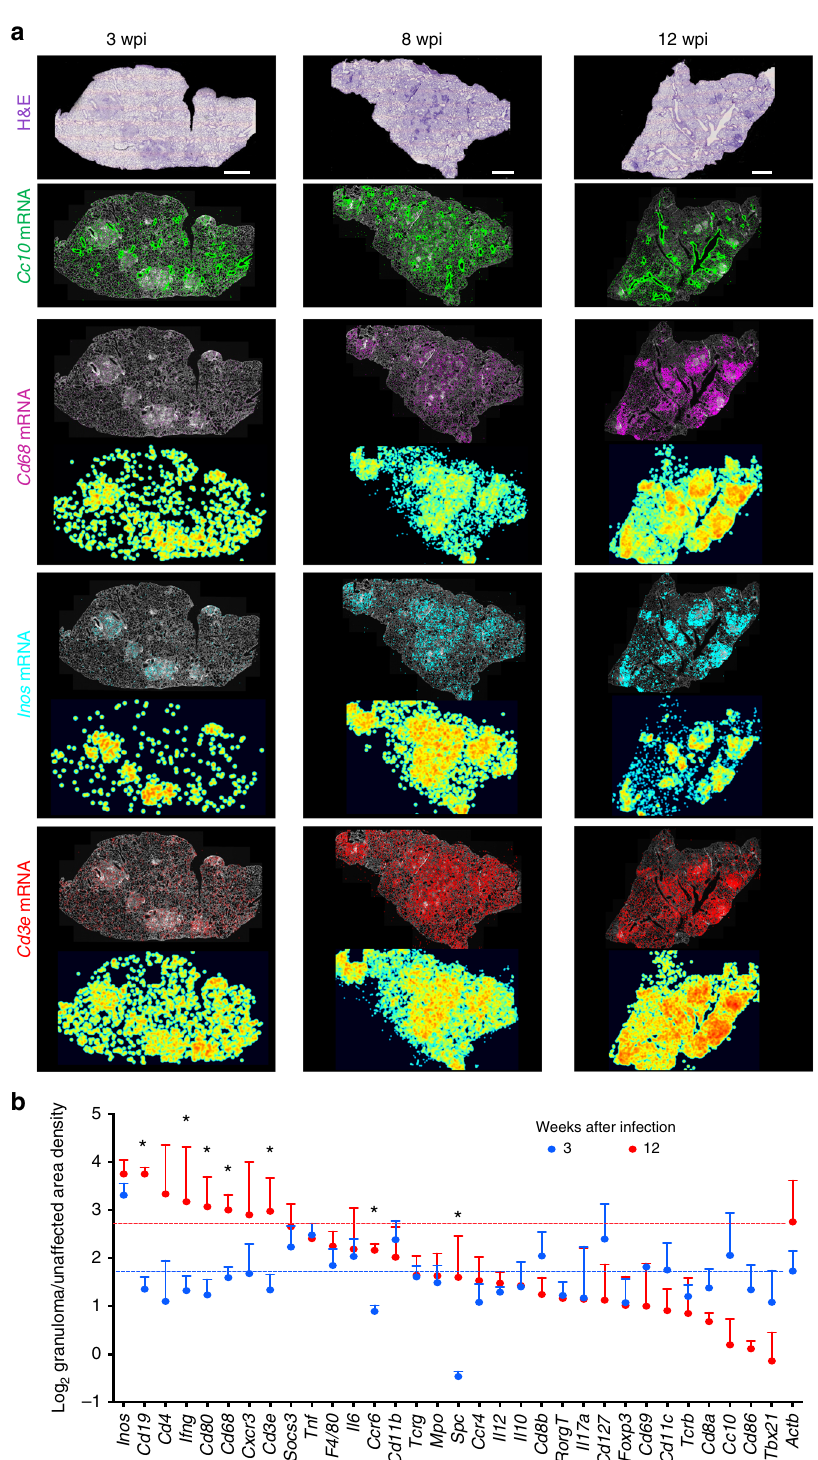
Fig. 1 Preferential localization of immune sequences in granulomas during infection with M. tuberculosis . a At 3, 8, and 12 weeks post M. tuberculosis infection (wpi), the fi xed lung tissue sections were stained with hematoxylin – eosin (H&E) and signals for Cc10 , Cd68 , Inos , and Cd3e were plotted on DAPI labeling as background. Pseudo-color density XY positional log 2 plots of transcript representations are shown below for Cd68 , Inos , and Cd3e transcripts. One representative of three consecutive sections is displayed. Scale: 1000 μ m. b The ratio of ampli fi ed transcripts in granulomas vs. unaffected regions was calculated for each transcript. The mean log 2 ratio of transcript density in the granuloma in relation to the density in unaffected region + SEM in three consecutive sections is depicted. Sections from lungs at 3 and 12 wpi are compared. *Differences in relative transcript density at 3 and 12 wpi are signi fi cant ( p < 0.05 unpaired Student ’ s t -test). Source data are provided as a Source Data fi